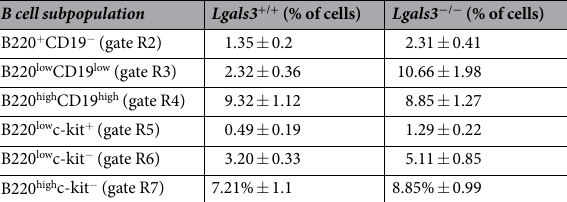
Table 1. Percentage of B cell subpopulations in the bone marrow of Lgals3 + / + and Lgals3 − / − mice. Data are plotted as means obtained from three independent experiments.